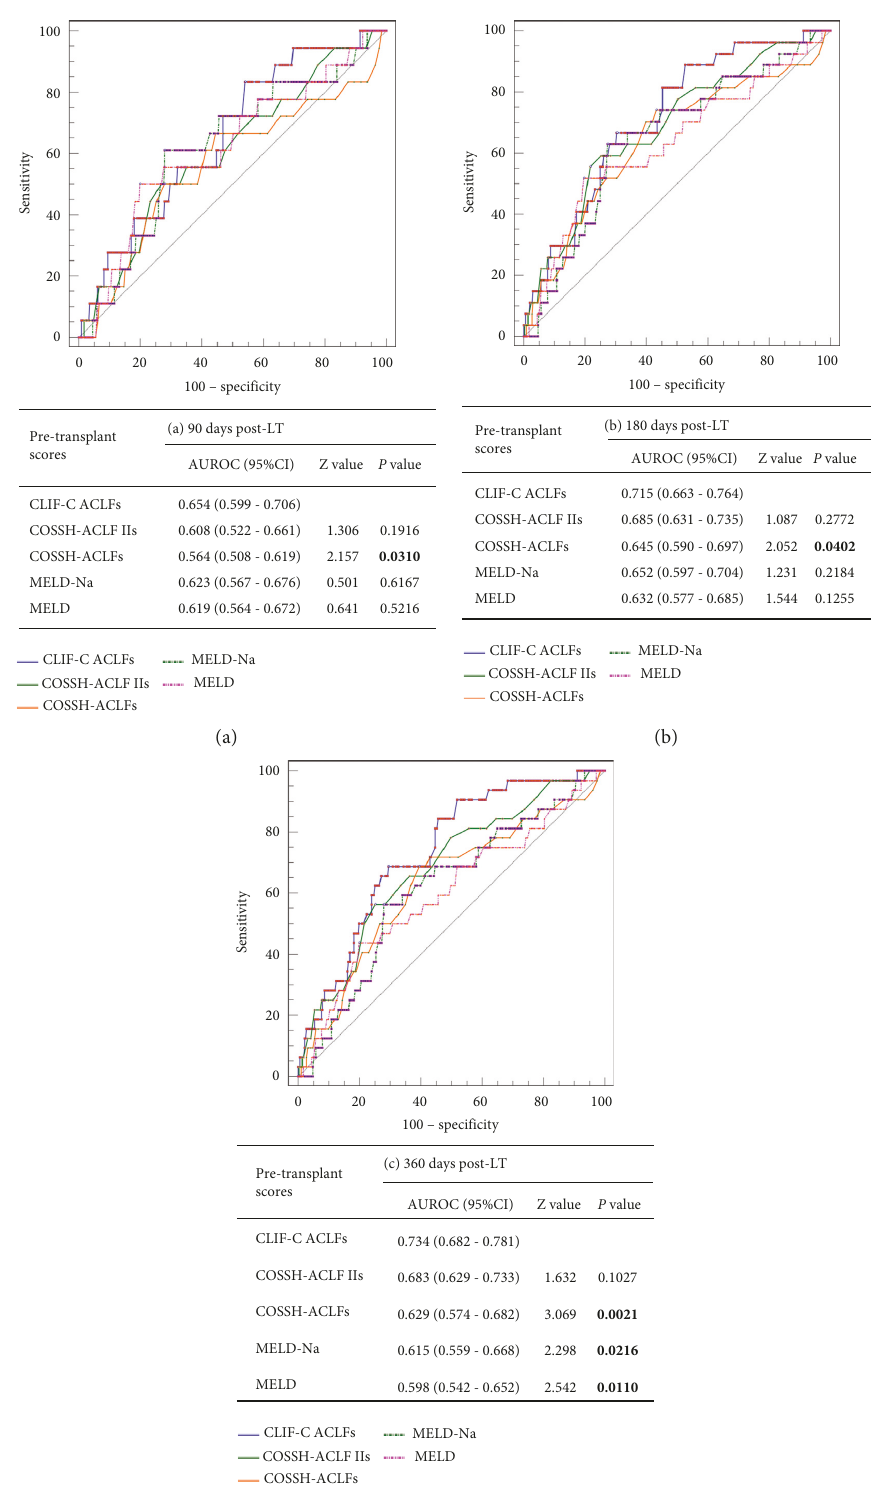
Figure 5: ROC curves and AUROC comparisons of the five pretransplant scoring systems predicting the survival probability of patients with HBV-ACLF (a) 90, (b) 180, and (c) 360 days after